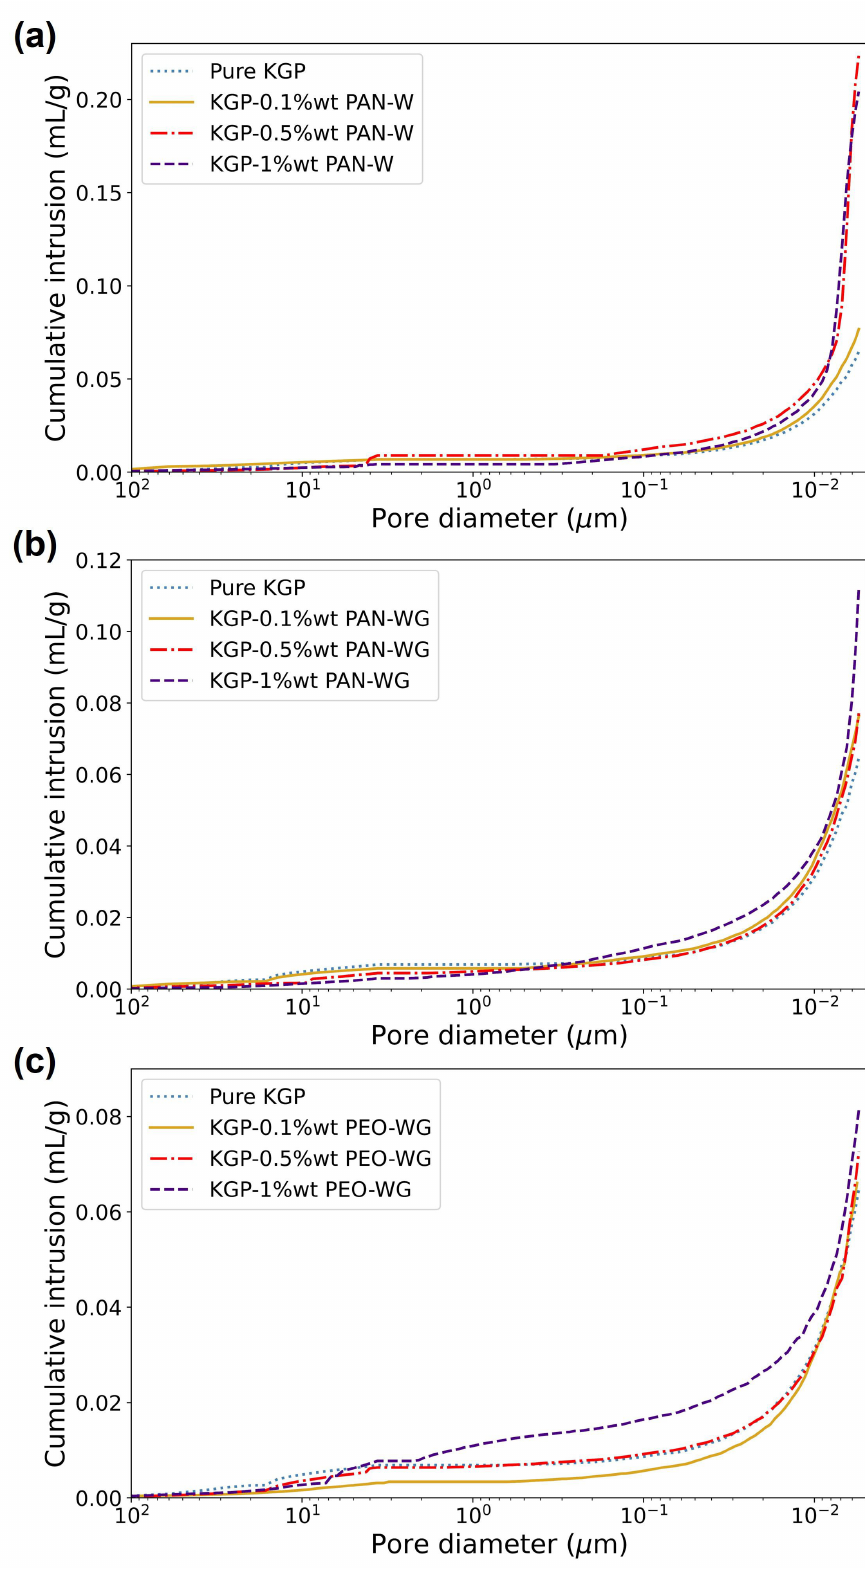
Figure 9. Cumulative MIP results of electrospun-fiber-reinforced geopolymer